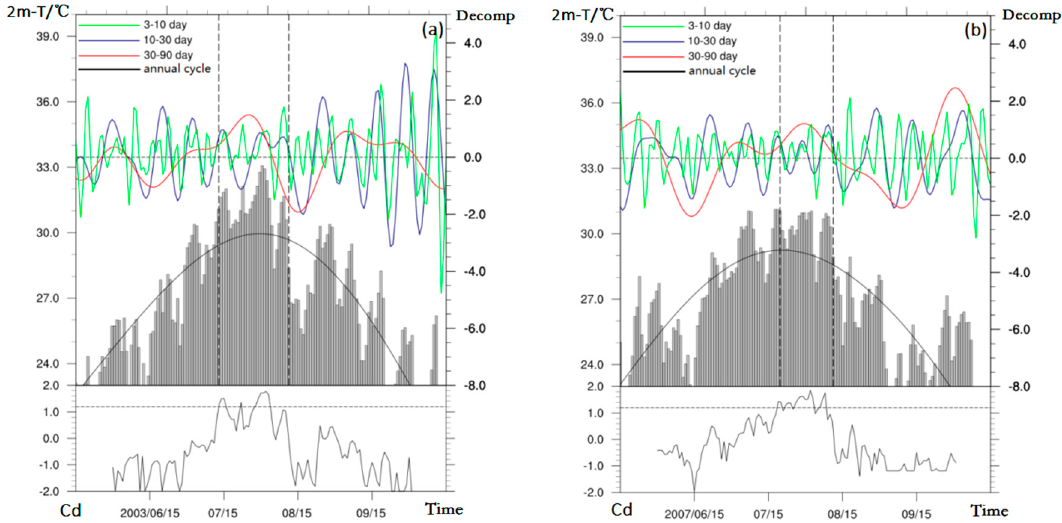
Figure 1. Temporal evolutions of area-mean (25 ◦ N–30 ◦ N, 113 ◦ E–118 ◦ E) daily 2 m air temperature (2 m-T) ( ◦ C, gray bars) and associated decompositions (Decomp): the climatological annual cycle across 2000–2017, 3-to-10-day synoptic disturbances, 10-to-30-day and 30-to-90-day intra-seasonal variability (the four solid lines in the top panel) along with (bottom panel) the daily compound indices (Cd) for two typical EHW events persisting more than 15 days, respectively, in ( a ) 2003 and ( b ) 2007 (Table 1). The time periods of two EHW events are highlighted within two vertical dashed lines in the two top panels of ( a , b ).